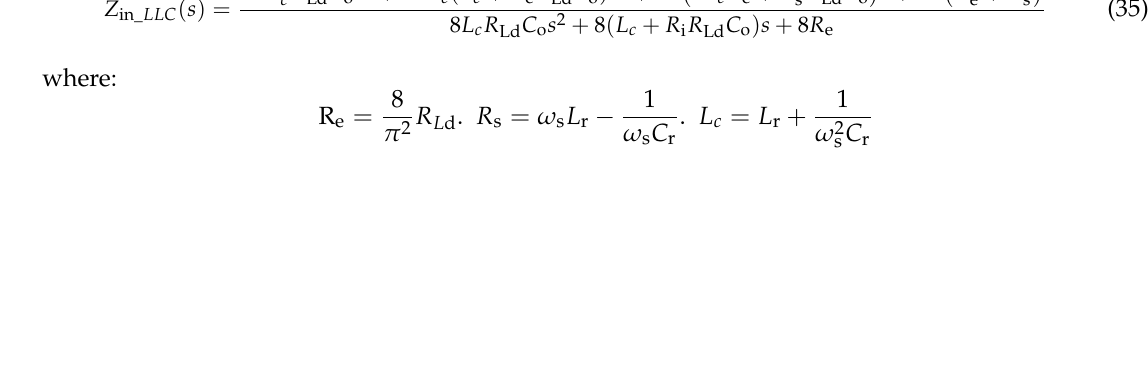
Figure 11. The output impedance model of LLC resonant converter can be deduced.